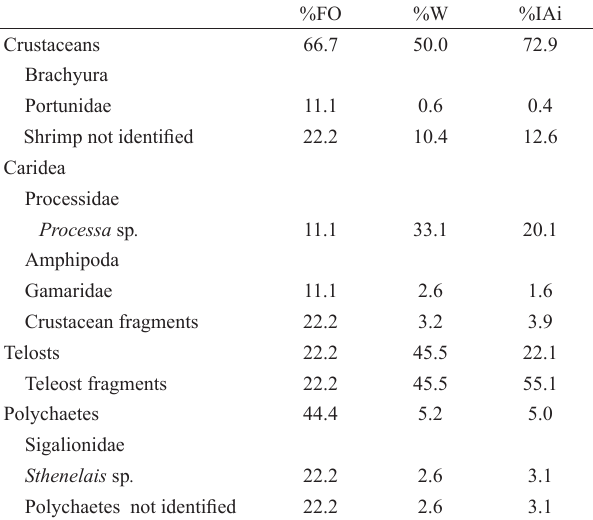
Tab. 2. Frequency of occurrence (%FO), percentage weight (%W) and alimentary index (%IAi) of prey items in the